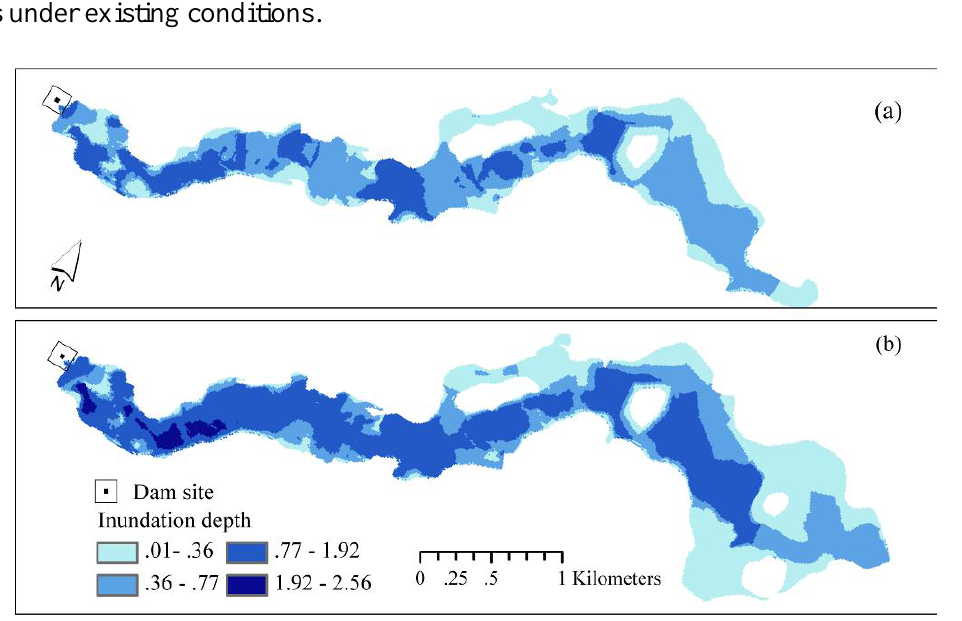
Figure 6. Modeled maps of inundation depths in (a) 50-year floods and (b) dam-failure floods under existing